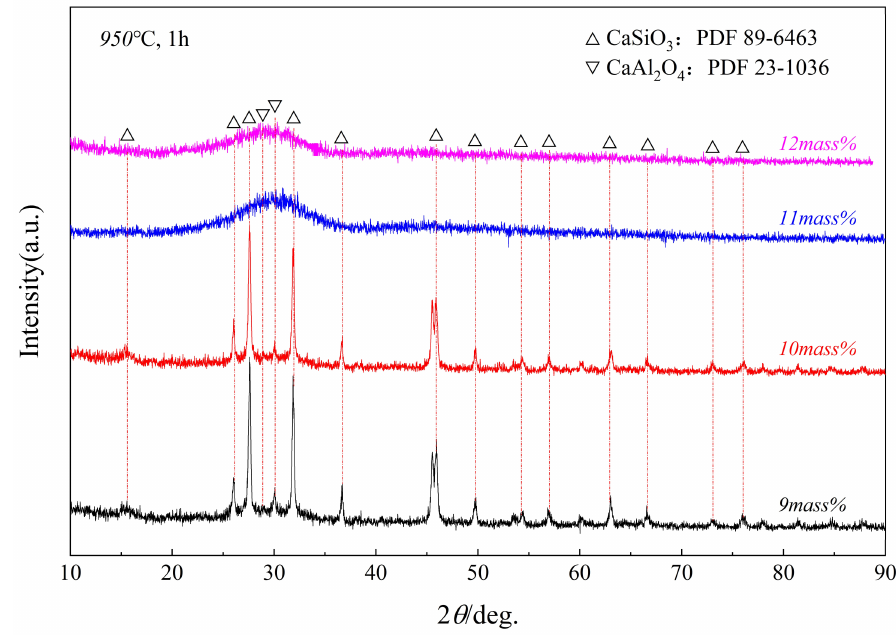
Figure 9. XRD patterns of samples of glass phases with different Al 2 O 3 contents after being held at a constant temperature of 950 ◦ C for 1 h.